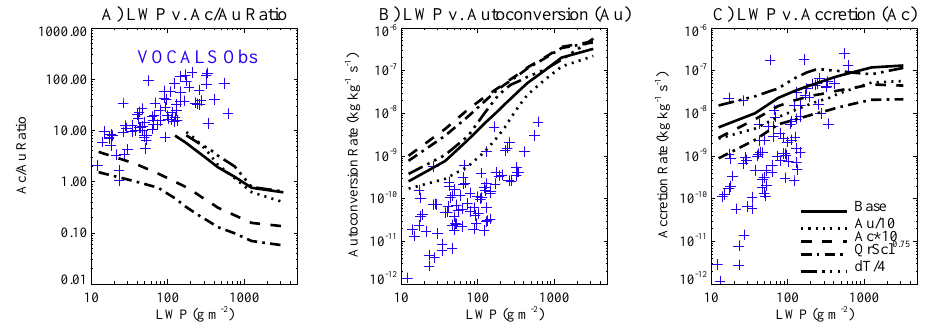
Fig. 8. Global averages of vertically averaged (A) accretion/autoconversion ( A c /A u ) ratio v. LWP, (B) Autoconversion ( A u ) rate v. LWP and (C) Accretion ( A c ) rate v. LWP. Simulations are described in Table 2. Base CAM5 (solid), Au/10 (dotted), Ac · 10: (dashed), QrScl 0 . 75 (Dot Dashed) and d T/ 4 (triple dot-dash). Also shown are observational estimates (blue crosses) from VOCALS aircraft flights as described in the text.